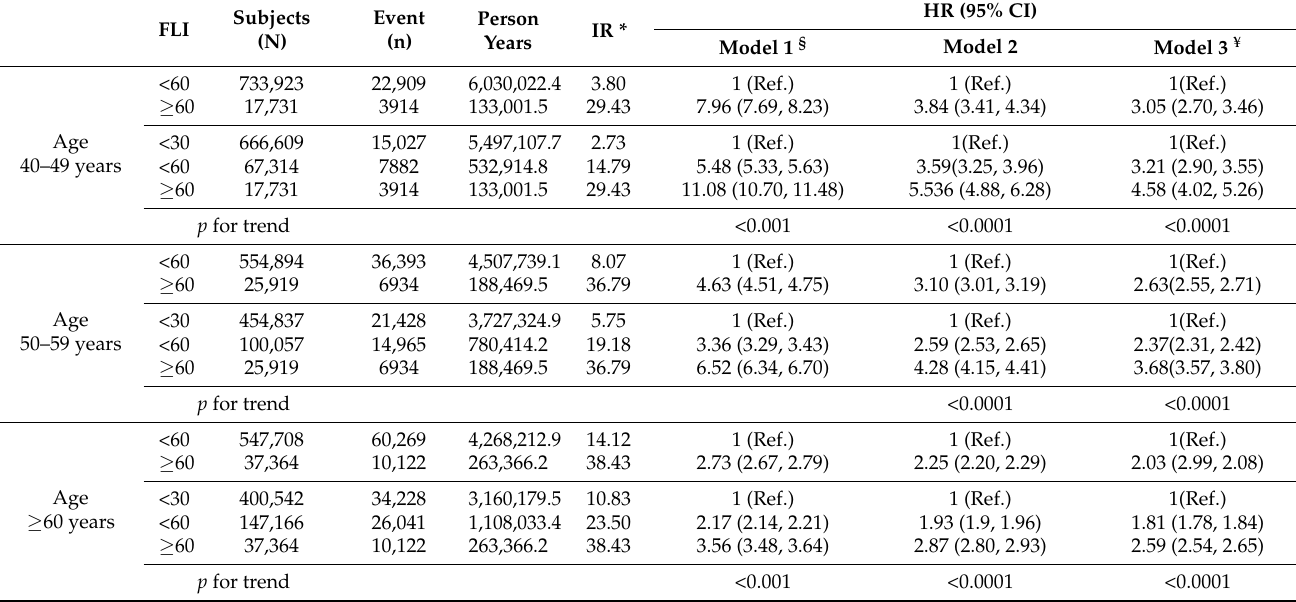
Table 4. Associations between fatty liver index and type 2 diabetes mellitus risk according to age.